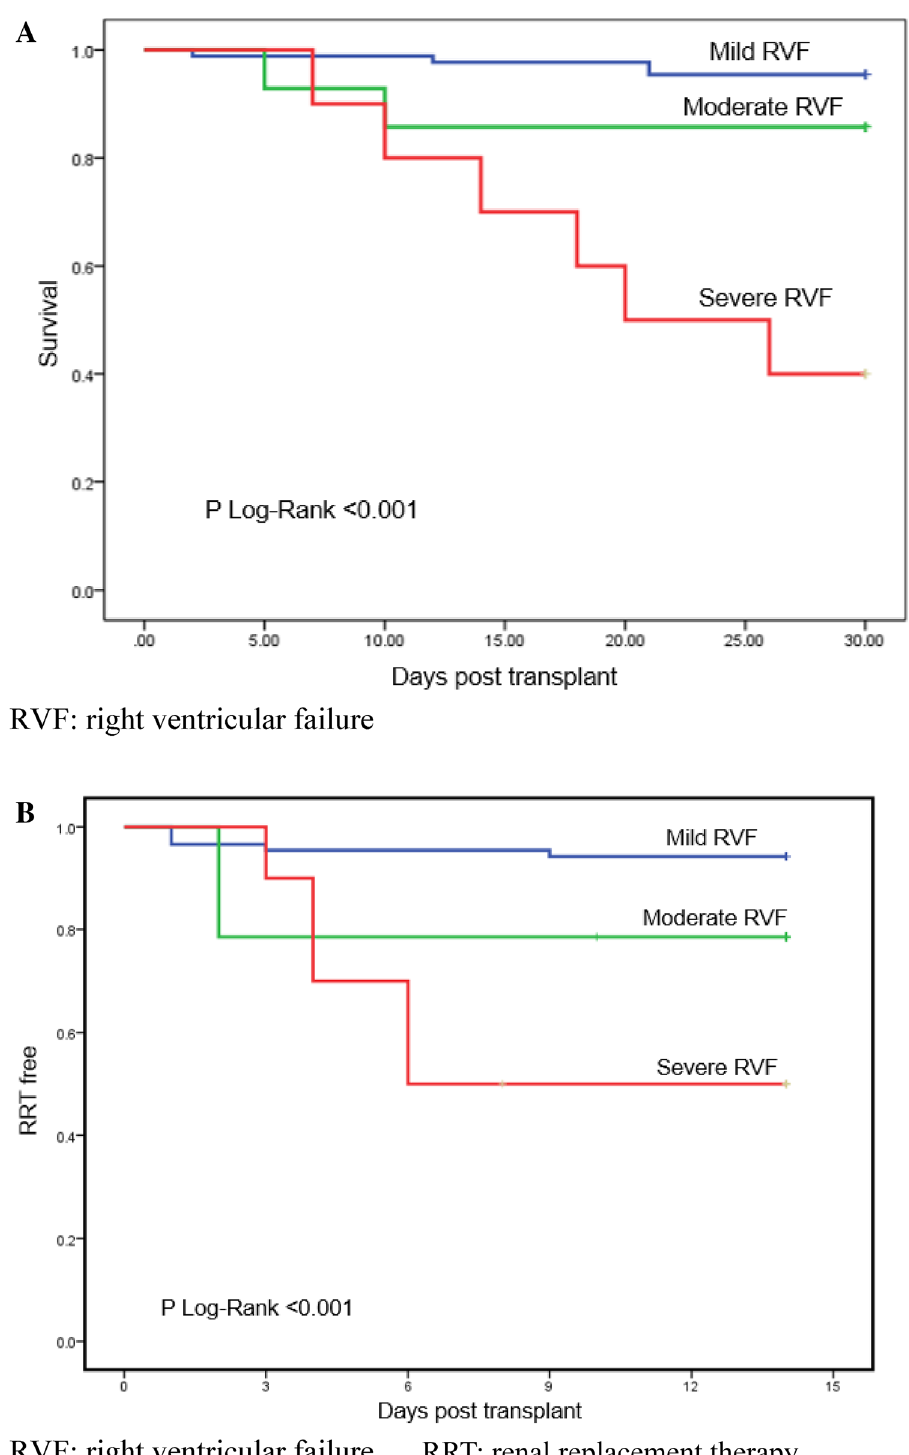
Figure 4. ( A ) Kaplan–Meier of 30-day survival in patients with primary isolated mild, moderate, severe right ventricular failure (RV) post-transplant. ( B ) Kaplan–Meier of dialysis-free survival curves in patients with mild, moderate, severe right ventricular failure